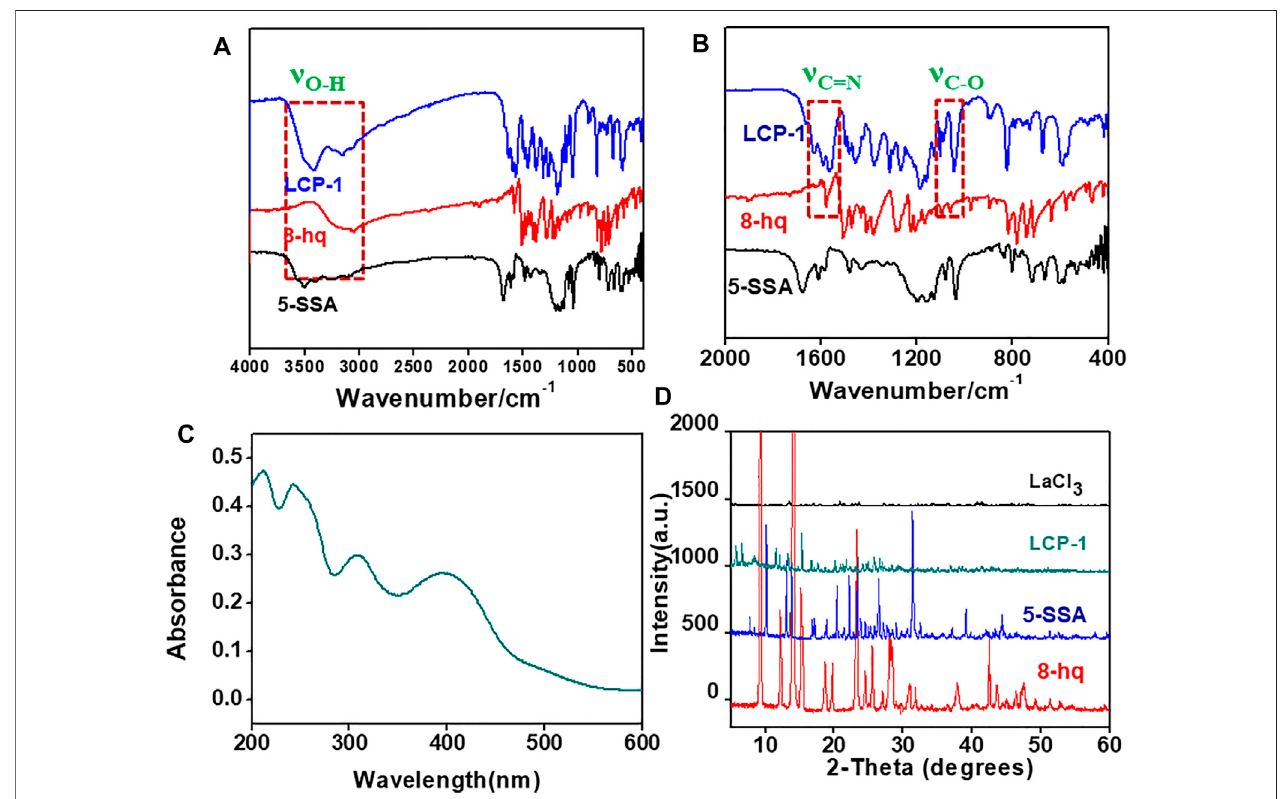
FIGURE 3 | FT-IR spectra of CP-1 and the reactants (A) , the ampli fi cation from 2000 cm − 1 to 400 cm − 1 (B) , UV – Vis spectra of LCP-1 (C) , and XRD patterns of LCP-1 (D)